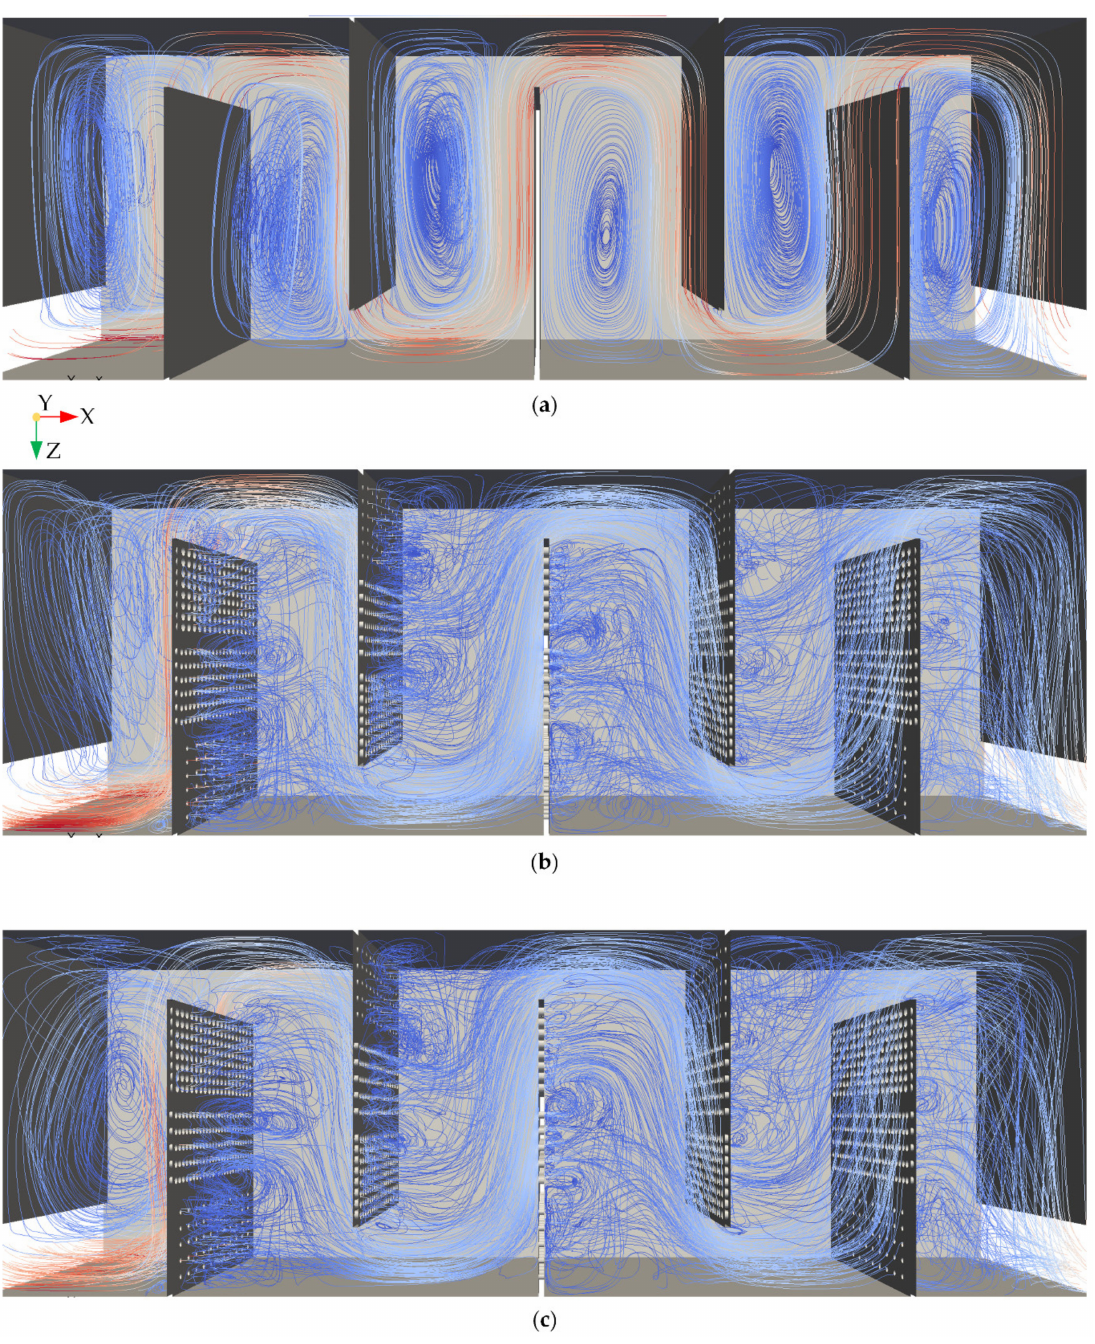
Figure 8. Visualization of three-dimensional streamlines for ( a ) conventional design; ( b ) Design 2; ( c ) Design